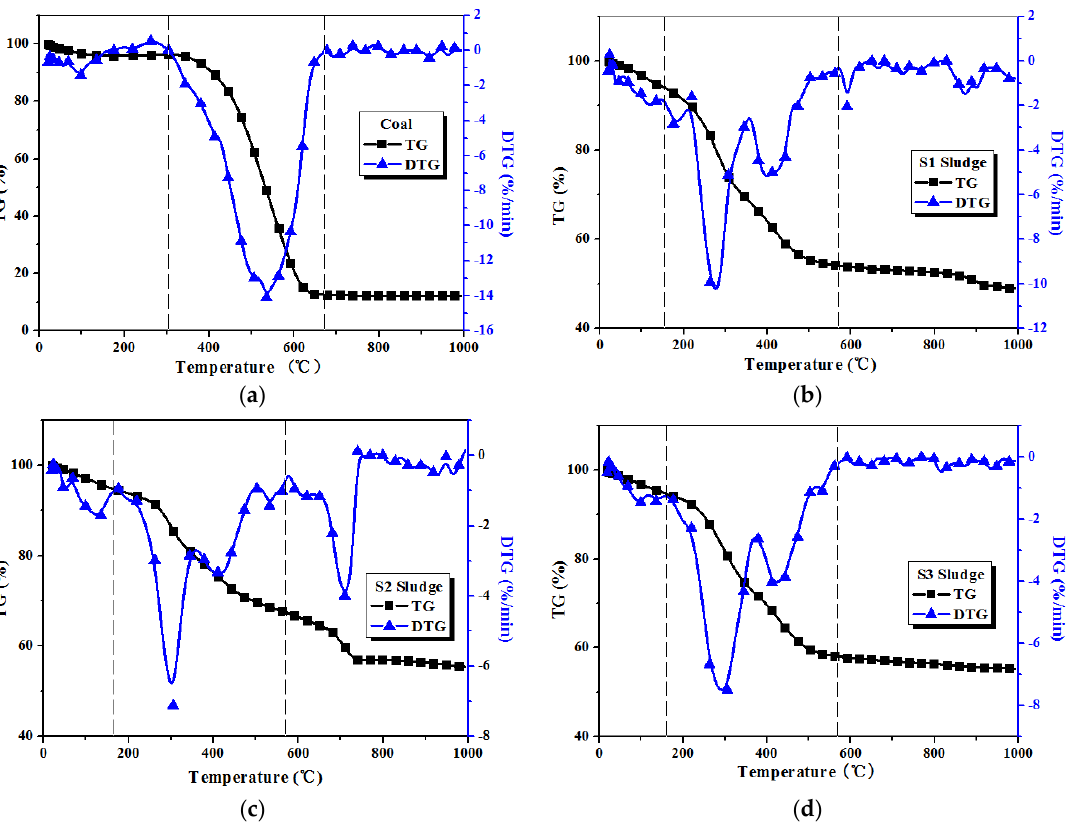
Figure 1. Thermogravimetric (TG) and differential thermogravimetric (DTG) curves for coal and sludge samples (heating rate = 30 °C/min) (( a ) coal; ( b ) S 1 ; ( c ) S 2 ; ( d ) S 3 ).